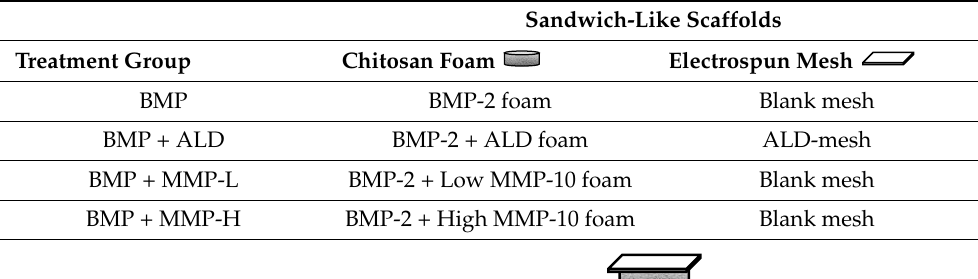
Table 3. Treatment groups for the in vivo assessment of scaffold performance. The same treatment groups were used for control mice (non-OP group) and osteoporotic mice (OP group).